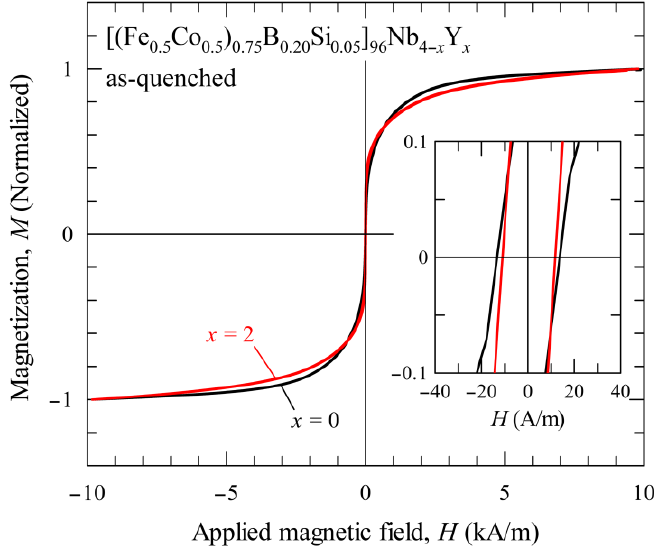
Figure 7. Hysteresis loops of [(Fe 0.5 Co 0.5 ) 0.75 B 0.20 Si 0.05 ] 96 Nb 4− x Y x ( x = 0, 2) alloys in an as-quenched state. Inset shows enlarged view near the origin.